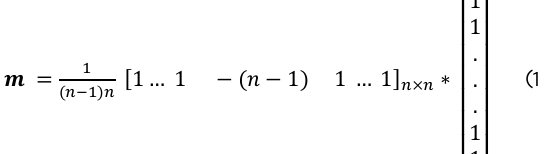
Figure 1. ‘Circularly symmetric neighbour sets’ for P=8